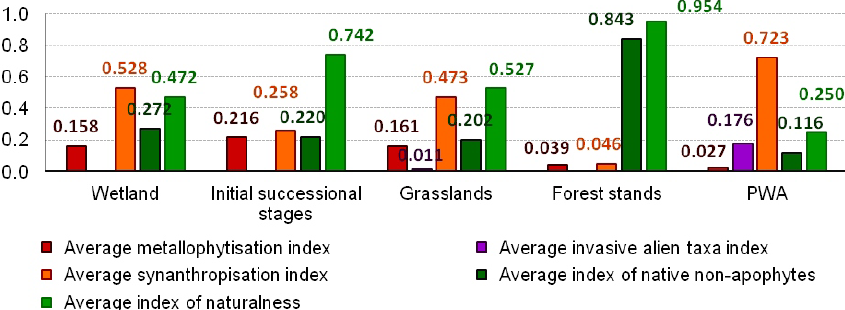
Figure 4. Average indexes of metallophytisation, invasive alien species, synanthropisation, non-native apophytes and naturalness index, according to individual